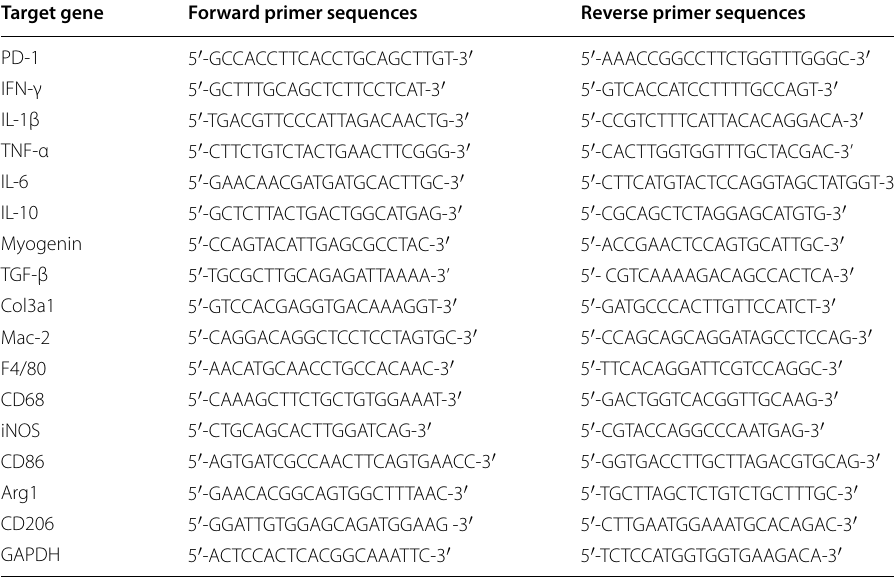
Table 1 Primer sequences for real-time PCR Target